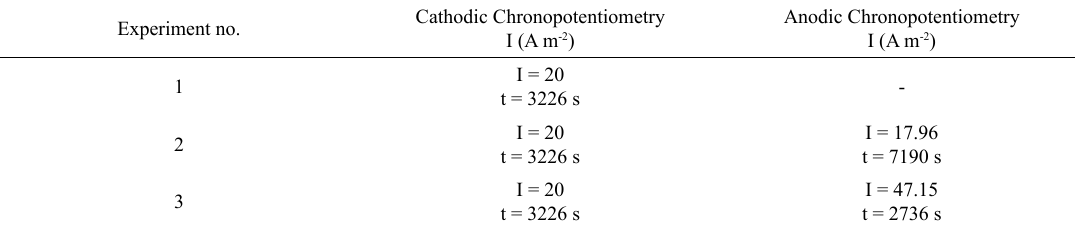
Table 1. Experimental conditions used to produce the Ni:Co oxide coatings Experiment